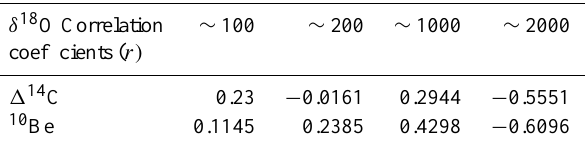
Table 3. Correlation coefficients ( r)δ 18 O with 1 14 C and 10 Be at ∼ 100, 200, 1000 and 2000-yr time scales.